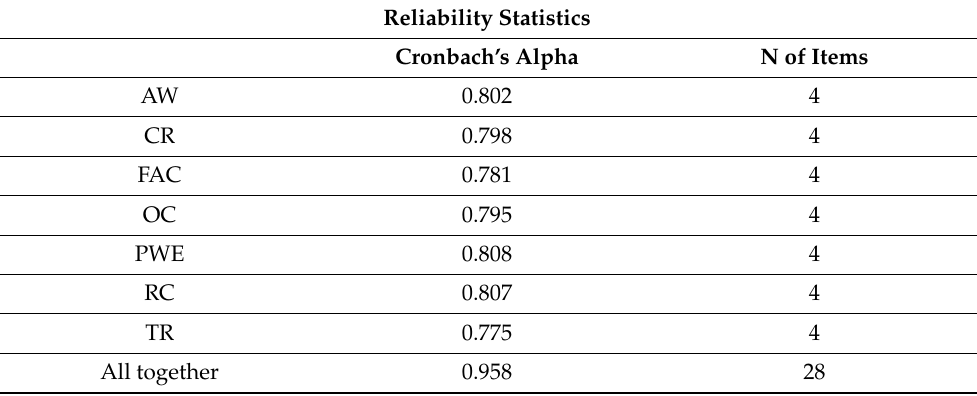
Table 2. Cronbach’s α : Data